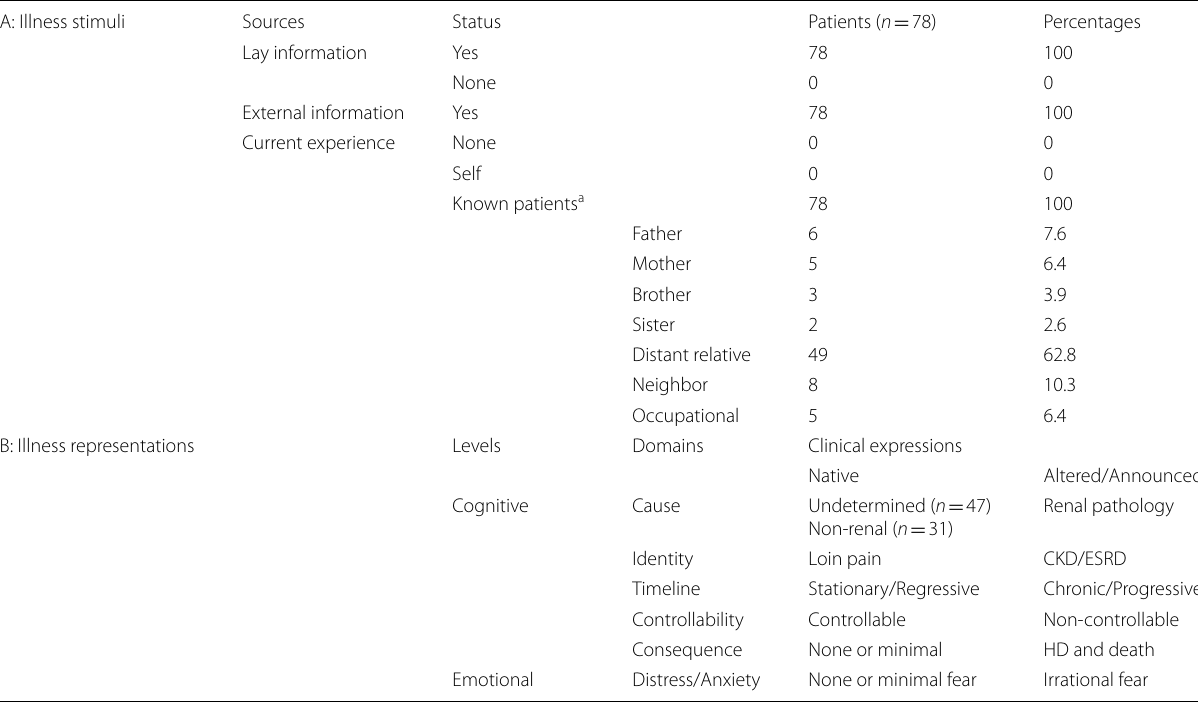
Table 2 Stimuli and representations of phobia of renal failure according to CSM